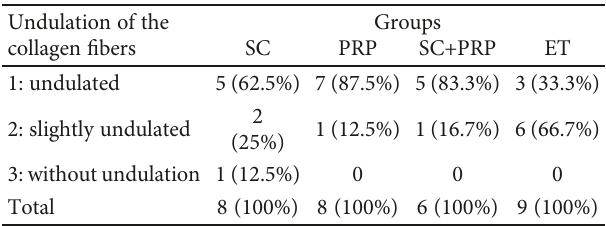
Table 6: Analysis of collagen fi ber